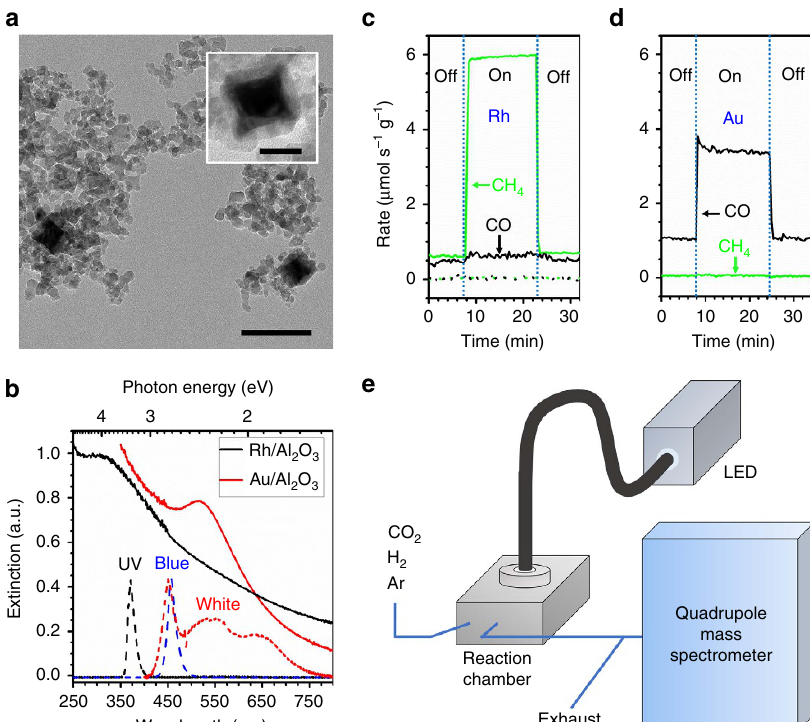
Figure 1 | CO 2 hydrogenation on the rhodium and gold photocatalysts. ( a ) TEM images of the Rh/Al 2 O 3 photocatalyst. Scale bar, 100nm (inset: 25nm). ( b ) Ultraviolet–visible extinction spectra (solid lines) of the Rh/Al 2 O 3 (black) and Au/Al 2 O 3 (red) photocatalysts, measured by diffuse reflectance in an integrating sphere, overlaid with the emission spectra (dotted lines) of the ultraviolet (black), blue (blue) and white (red) LEDs. ( c ) Rates of CH 4 (green) and CO (black) production at 623K on Rh/Al 2 O 3 (solid lines) and Al 2 O 3 (dotted lines) under dark and ultraviolet illumination at 3Wcm (cid:2) 2 . CH 4 production is strongly and selectively enhanced by ultraviolet light on the Rh photocatalyst. Neither CH 4 nor CO production was detected on Al 2 O 3 . ( d ) Rates of CO (black) and CH 4 (green) production at 623K on Au/Al 2 O 3 under dark and white light illumination at 3Wcm (cid:2) 2 . A light-enhanced reaction rate is observed, but CO remains the exclusive product under both conditions. ( e ) Schematic of the photocatalytic reaction system, consisting of a stainless steel reaction chamber with a quartz window, LEDs coupled through a light guide, and a mass spectrometer for product